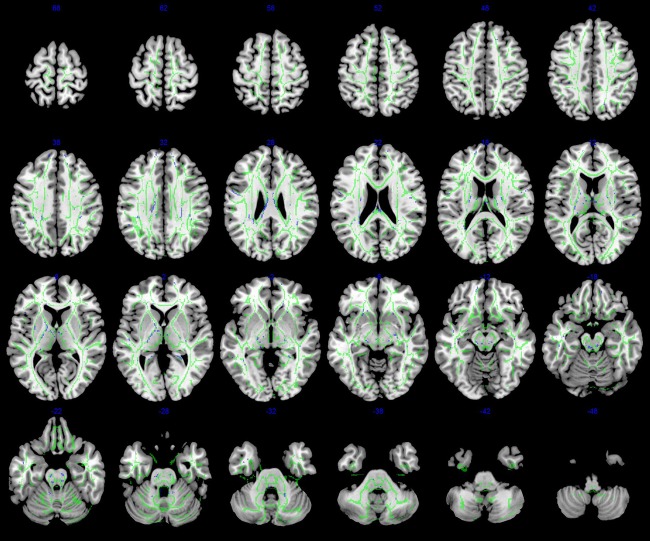
Voxel-wise correlation analysis between FA values and GMFCS levels on TBSS.Green is the mean white matter skeleton of all subjects; Areas in blue represent regions showing significant negative correlation between FA values and GMFCS levels. Reader's left is subject's left.